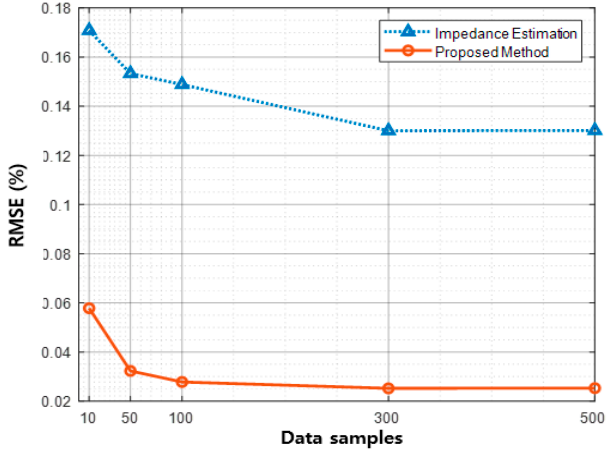
Figure 15. Effect of the data sample on the voltage prediction at 1.03 (p.u) slack node